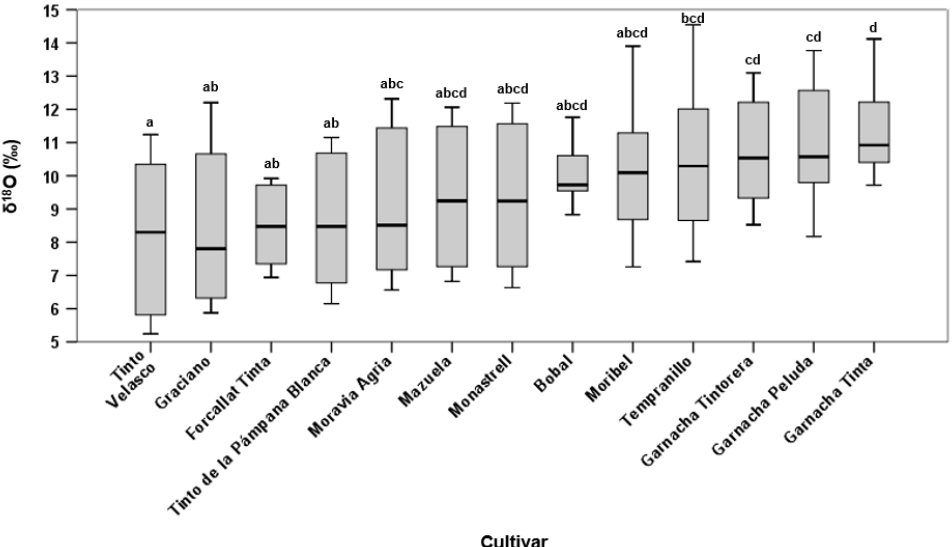
Figure 5. Oxygen isotope ratio ( δ 18 O) in grape musts at harvest time. The box plot illustrates the distribution of δ 18 O values of must from 13 red cultivars from 2018 to 2020. The results are ordered according to their means. The black solid line indicates the median and the box ends correspond to the 25th and 75th percentiles of the data. The error bars represent the 10th and 90th percentiles. The mean δ 18 O values of cultivars with different letters (a, b, c, and d) are significantly different at p < 0.001, as indicated by the S–N–K